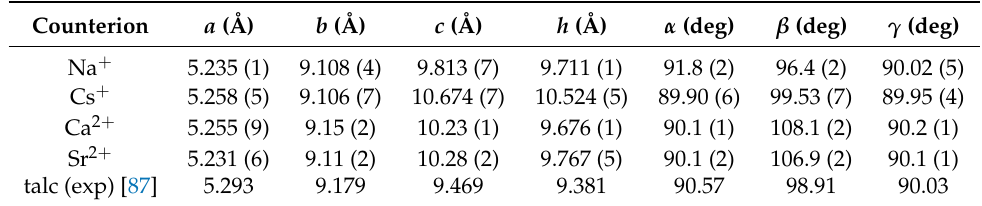
Table 5. Unit cell parameters of dry hectorites with the PIM model. The error on the last significant digit is reported between